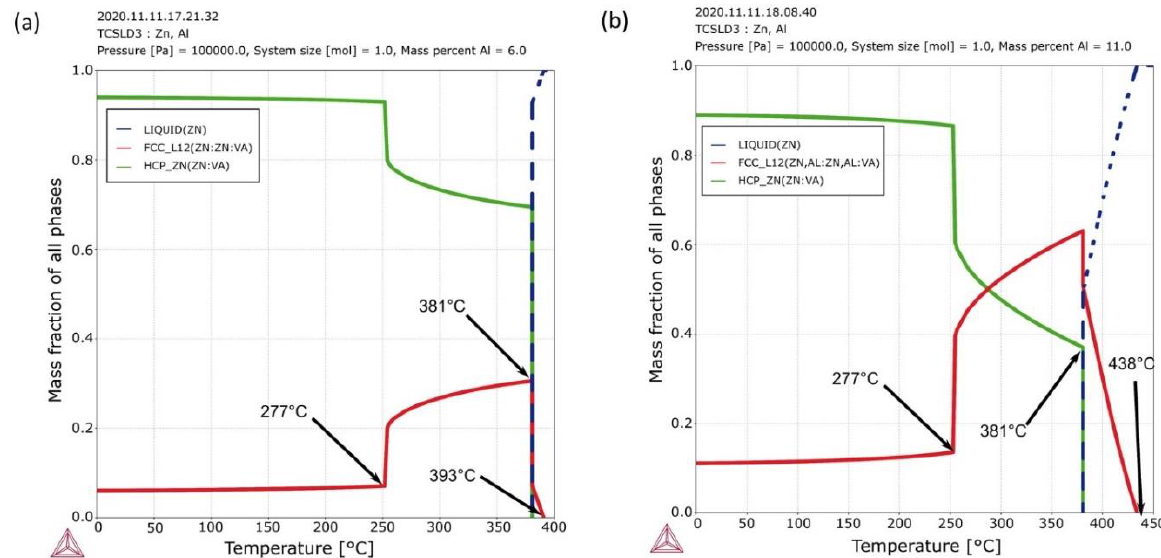
Figure 9. Equilibrium phase fractions versus temperature according to the ThermoCalc software, TCSLD3 Data base, for: ( a ) Zn-6wt.% Al and ( b ) Zn-11wt.% Al alloys [33].